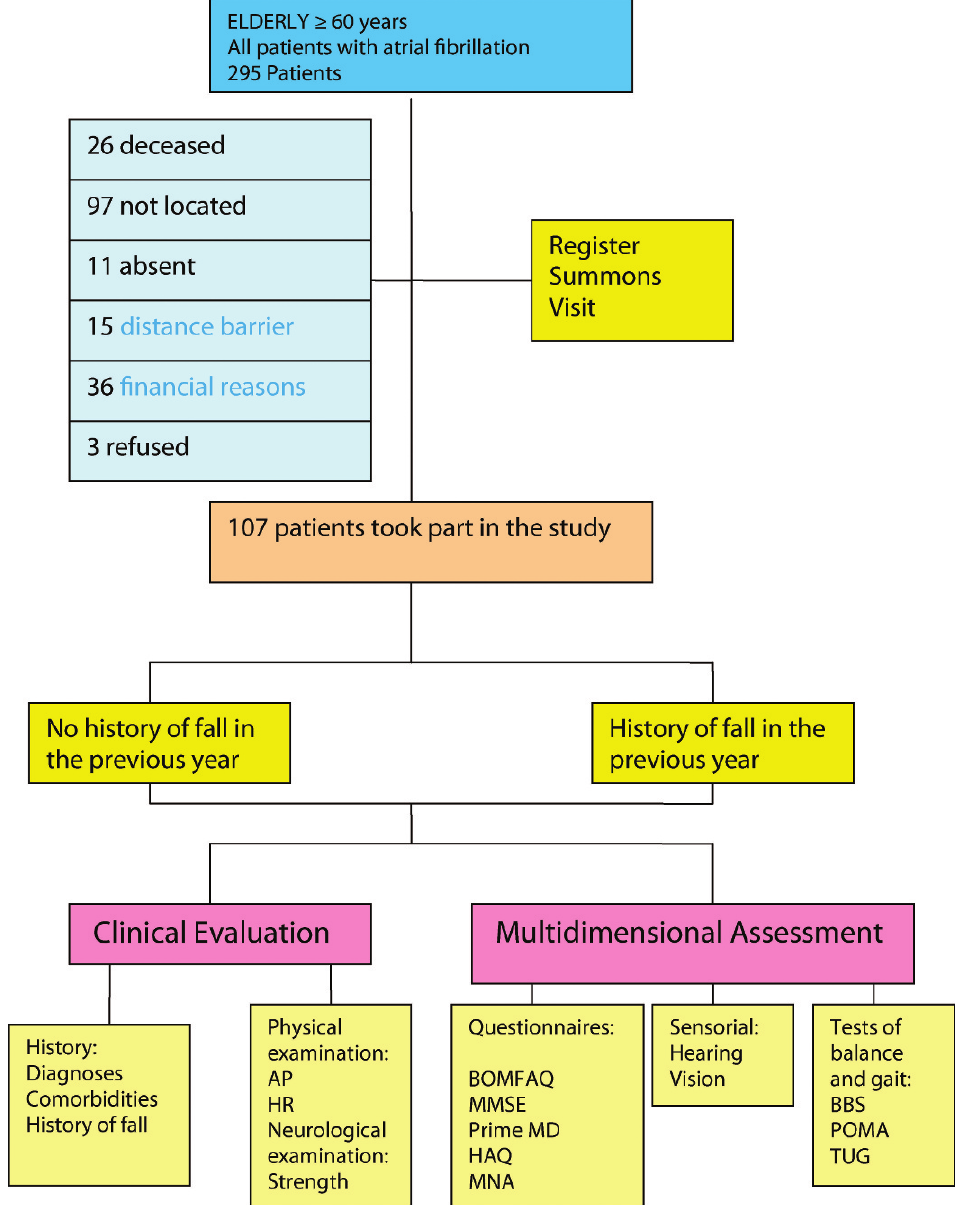
They had an advanced age (77.9 ¡ 6.4 years) and a predominance of shared dwellings (81.3%) and female gender (57.9%). Most patients reported cardiovascular symptoms (82.2%), were sedentary (80.4%), and used four or more medications (87%). The most frequent diagnoses were arterial hypertension (91%), osteoarthritis (47.7%), dyslipidemia (46.7%), New York Heart Association class I/II heart failure (41%), obesity (30.8%), diabetes mellitus (18.7%), and heart failure class III (12.2%). The presence of four or more comorbidities was frequent (44.9%). Patients were divided and compared according to the history of falls in the previous year (Table